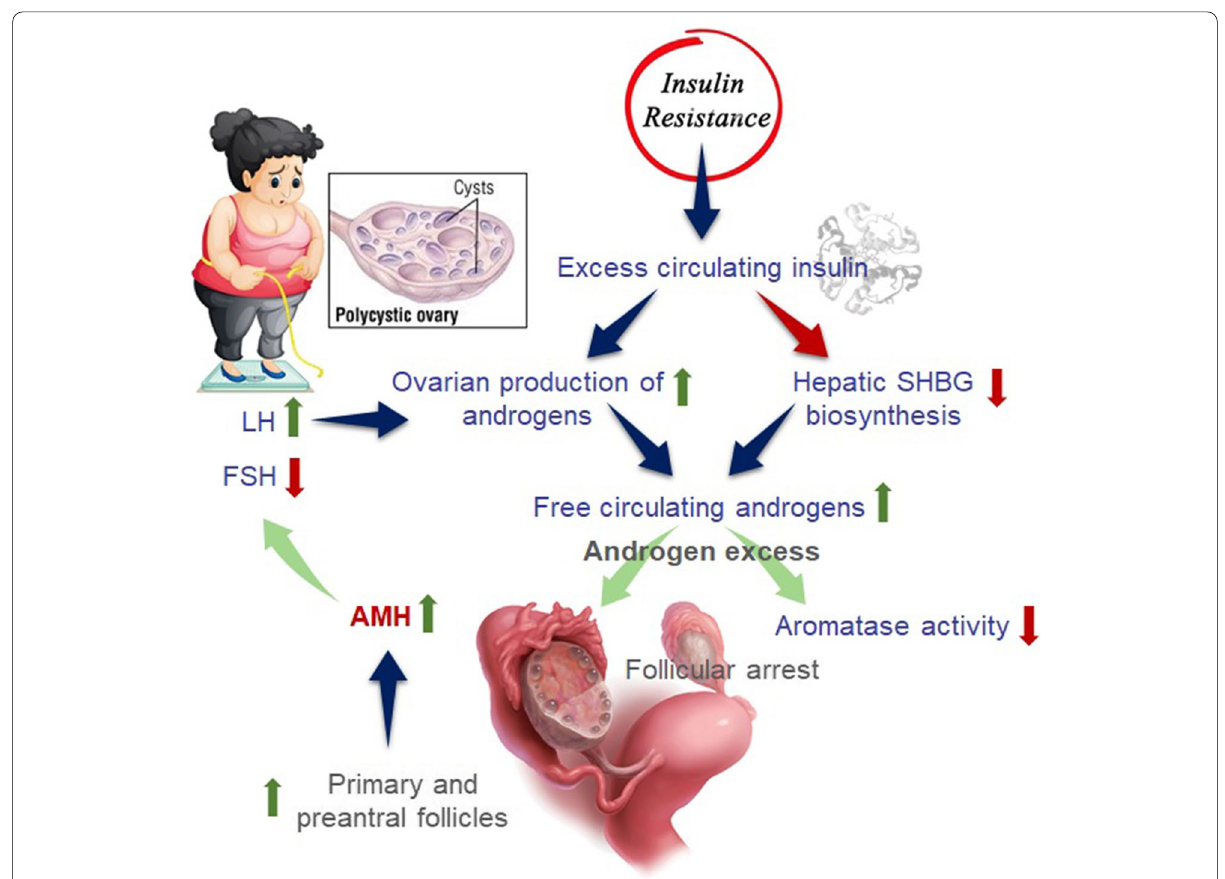
Fig. 1 Anti-Müllerian hormone (AMH) in the pathophysiology of polycystic ovary syndrome